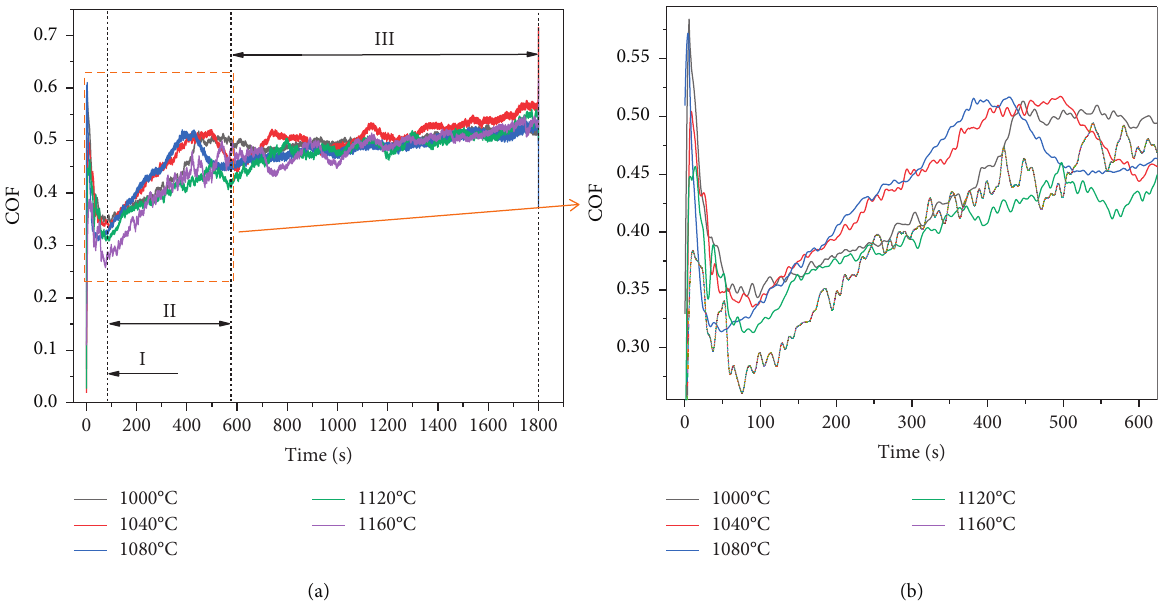
Figure 3: Relationship between friction coefficient and dry friction time at different solution